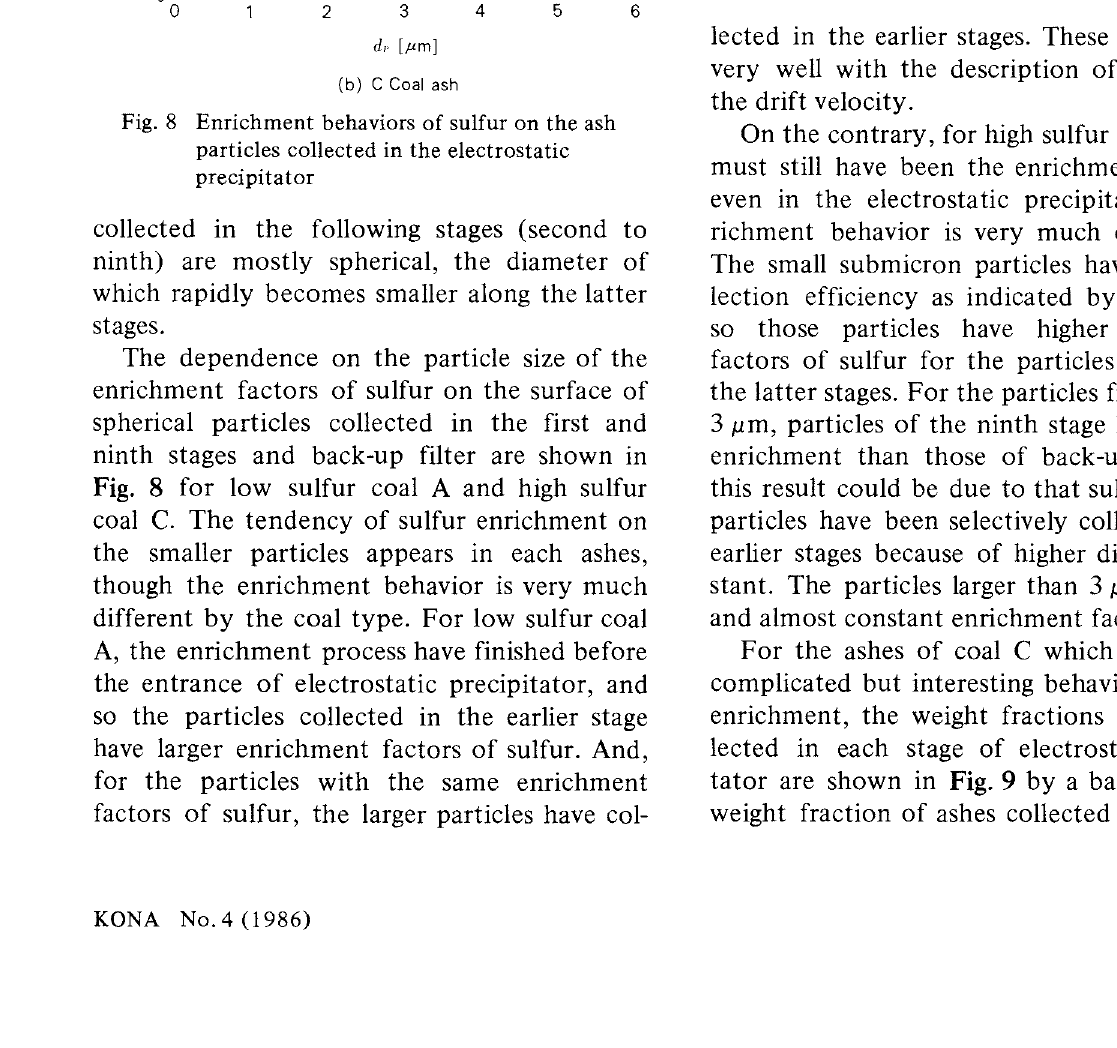
Fig. 9 Collection characteristics of ash particles in the stages of electrostatic